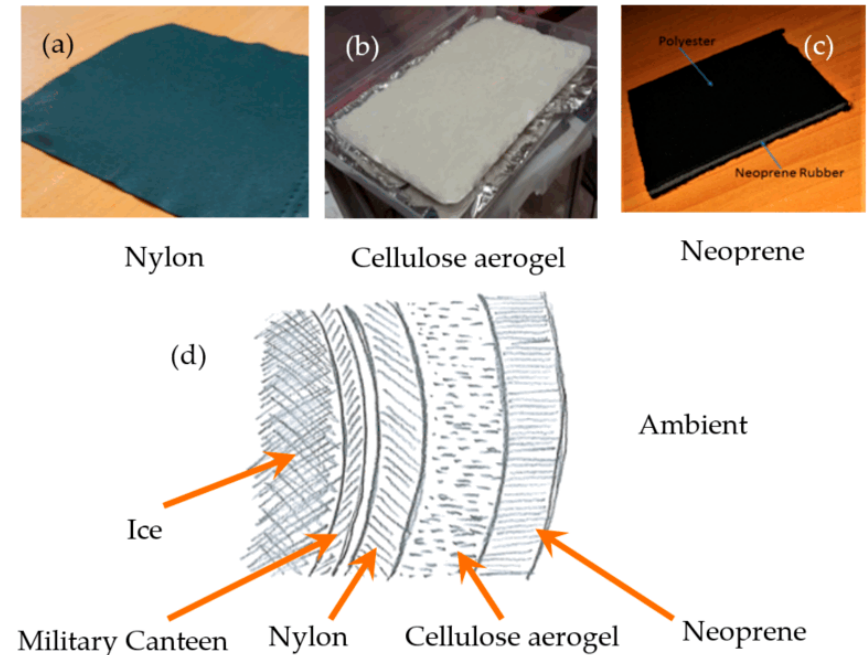
Figure 3. Materials of ( a ) nylon, ( b ) cellulose aerogel, ( c ) neoprene are used for the insulated jacket design, and ( d ) the sandwich structure consists of Neoprene as the outmost layer, the cellulose aerogel within and Nylon as the innermost layer.